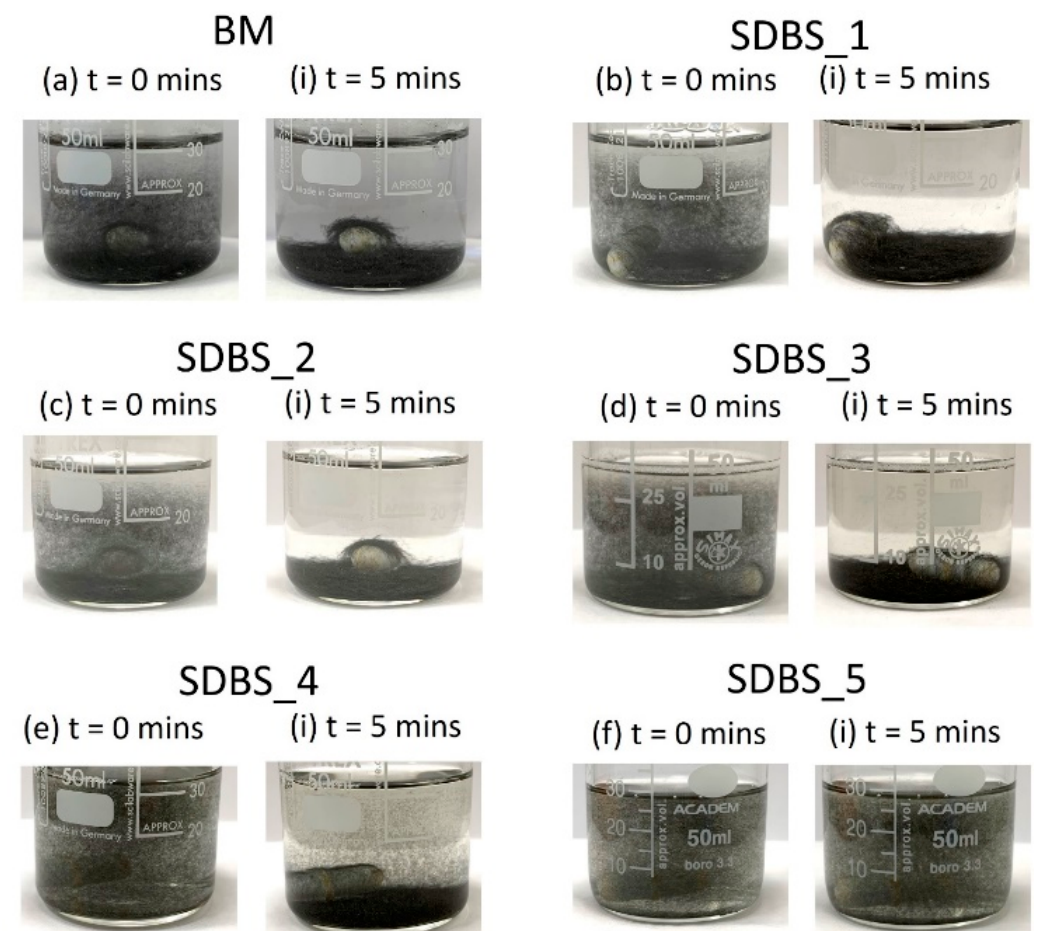
Figure 4. Dissolution experiment at t = 0 and t = 5 mins for different concentrations of SDBS ( b–f ), compared to the ( a ) benchmark sample (BM). Shorter fibres are suspended in SDBS_4, whereas the majority of fibre lengths are suspended in SDBS_5.